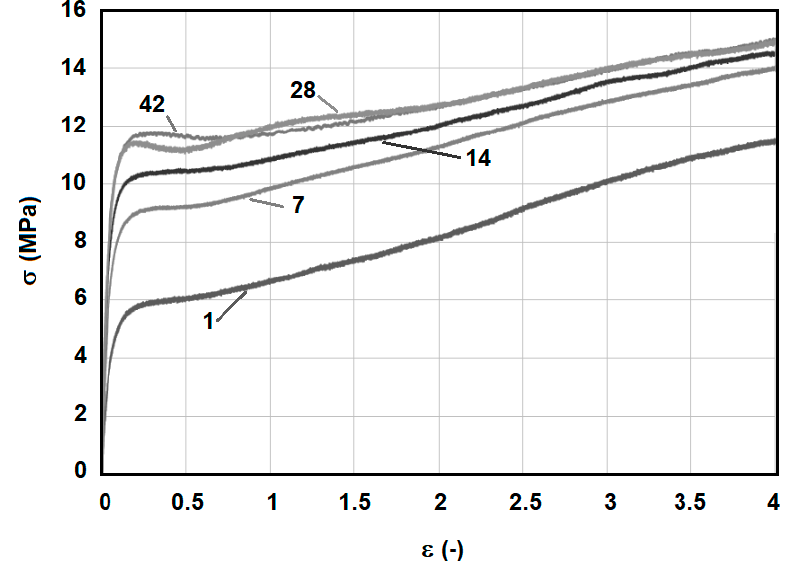
Figure 6. Stress–strain curves at different aging times (from 1 to 42 days).